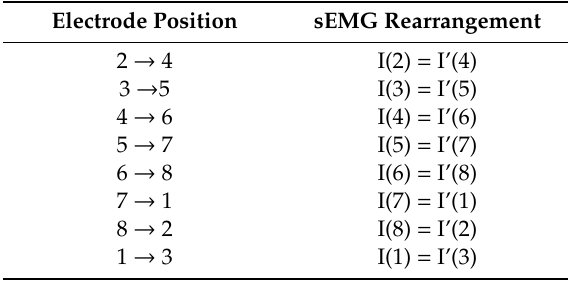
Table 1. The relation between raw and shifted channel.